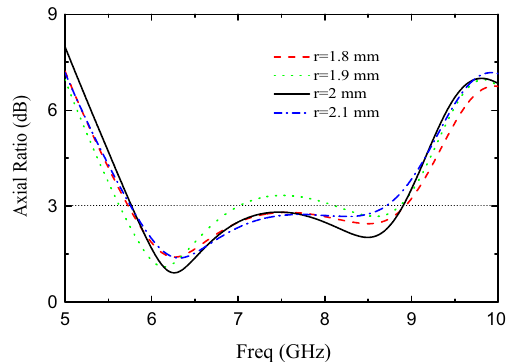
Fig. 7 Influence of radius r of coupled circular patch on antenna AR performance